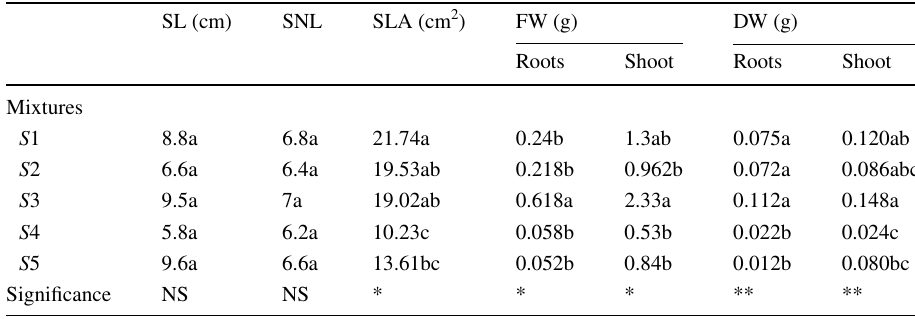
Table 2 Lettuce growth attitude on a linear substitution of commercial peat